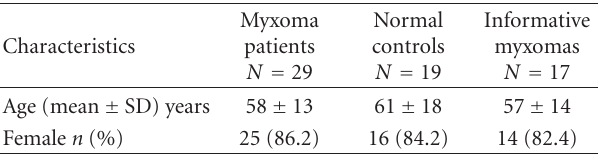
Table 1: Characteristics of the myxoma patients (all and informa- tive cases) and the normal controls; no statistical significance was observed in baseline characteristics between